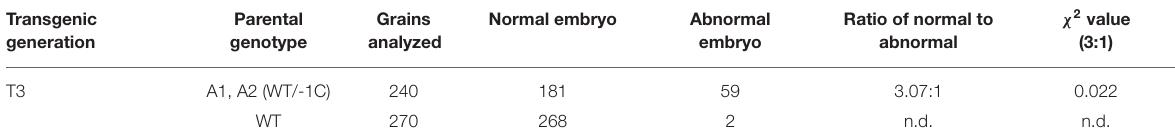
TABLE 5 | Characterization of the embryos extirpated from the mature grains of heterozygous mutant (WT/ − 1C) plants. Transgenic generation